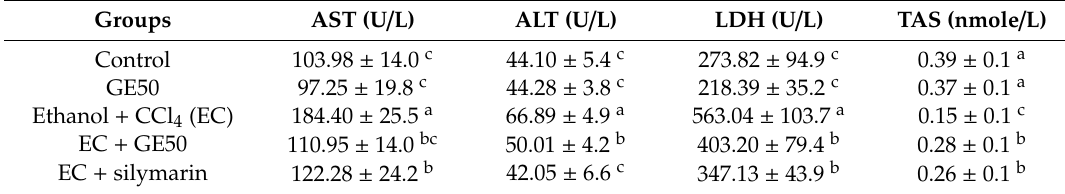
Table 2. E ff ects of oral administration of GE50 over six consecutive weeks on serum aspartate aminotransferase (AST), alanine aminotransferase (ALT), and lactate dehydrogenase (LDH) levels, and total antioxidant status (TAS) in rats treated with ethanol + CCl 4